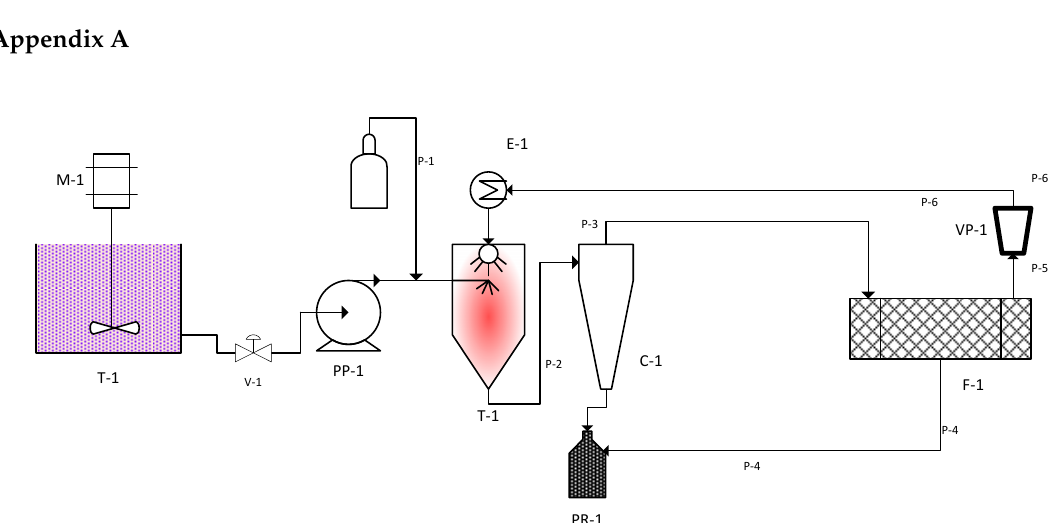
Figure A1. Spray drying technology general layout. Legend: M-1: Electric motor for stirrer; T-1: Emulsification tank; V-1: Valve; PP-1: Pump for emulsion feeding into the atomisation tower T-1 of the spray dryer; P-1: Compressed fluid (air or nitrogen) line used for spray atomisation; E-1: Heating system for the drying fluid fed into the atomisation tank; P-2: Line for dried product to be recovered through the cyclone C-1; PR-1: Product collector as underflow from the cyclone; P-3: Line for the overflow separated from the fluid (air / N2) through a filter F-1; P-4: Line of the solid product recycled from the filter F-1; P-5: Fluid (Air / N2) separated from solid particles feeding into a vacuum pump VP-1 to be recycled by line P-6 back to the drying tower T-2 after being heated-up through E-1